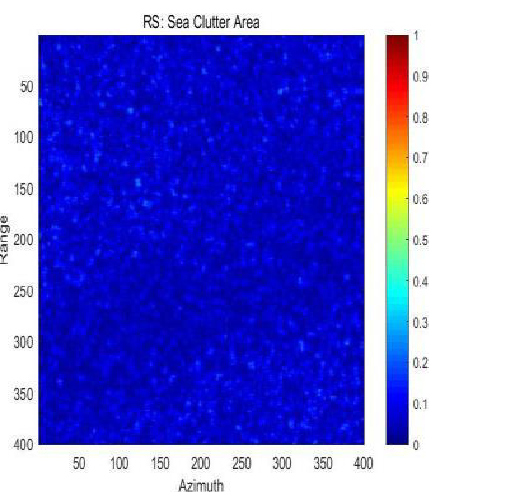
Figure 5. DoD values. ( a ) The sample area of sea clutter; ( b ) S1. Note that the units of the colorbar are normalized.